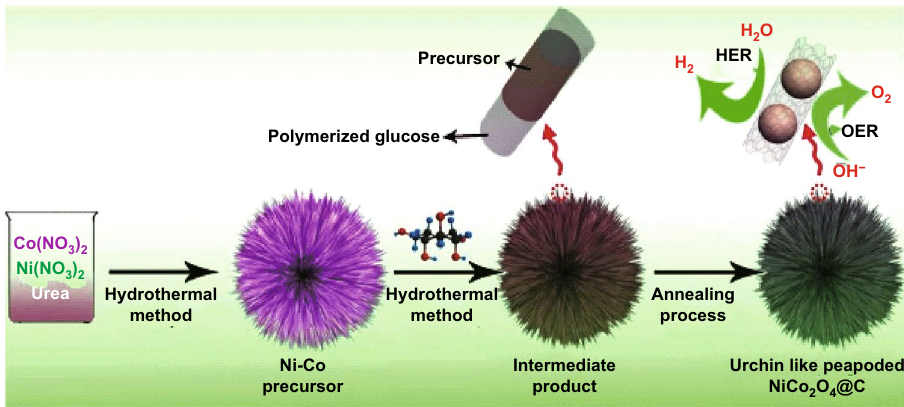
Fig. 6 Schematic diagram of the process of urchin-like peapoded NiCo 2 O 4 @C. Reproduced with permission from Ref. [119], Copyright © 2017 Elsevier B.V.